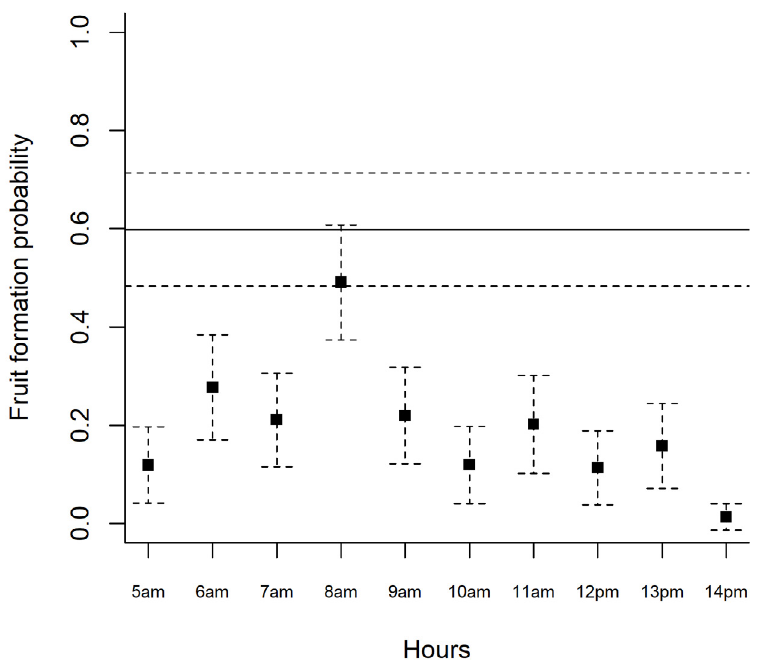
Fig 4. Effect of time of day on fruit formation probability. Squares are mean for each period, and the continuous line is the control mean (treatment exposed all the time). The dashed line is 95% confidence intervals.